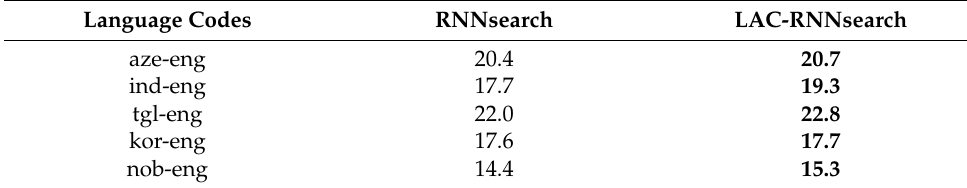
Table 4. Comparison of low-resource Corpora.